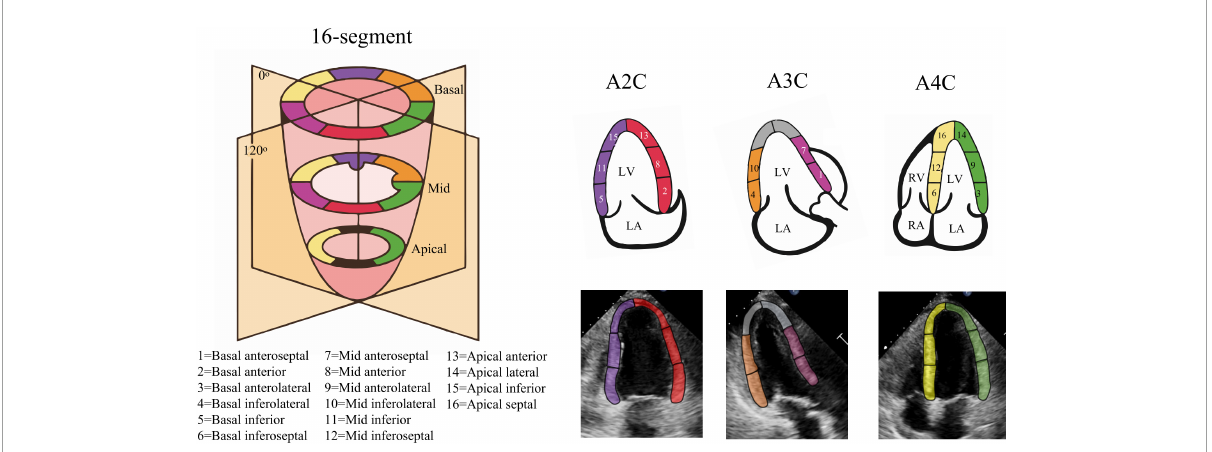
FIGURE2 Echocardiography 16-segment. The 2015 ASE guideline recommend that the left ventricular myocardium be divided into three rings, namely the basal ring, the mid ring, and the apical ring, each with a height 1/3 of the length of the left ventricle. The basal ring and the mid ring contain six segments, respectively, and the apical ring contains four segments. The actual echocardiogram corresponds to the diagram above. The colors indicate different supplying coronary